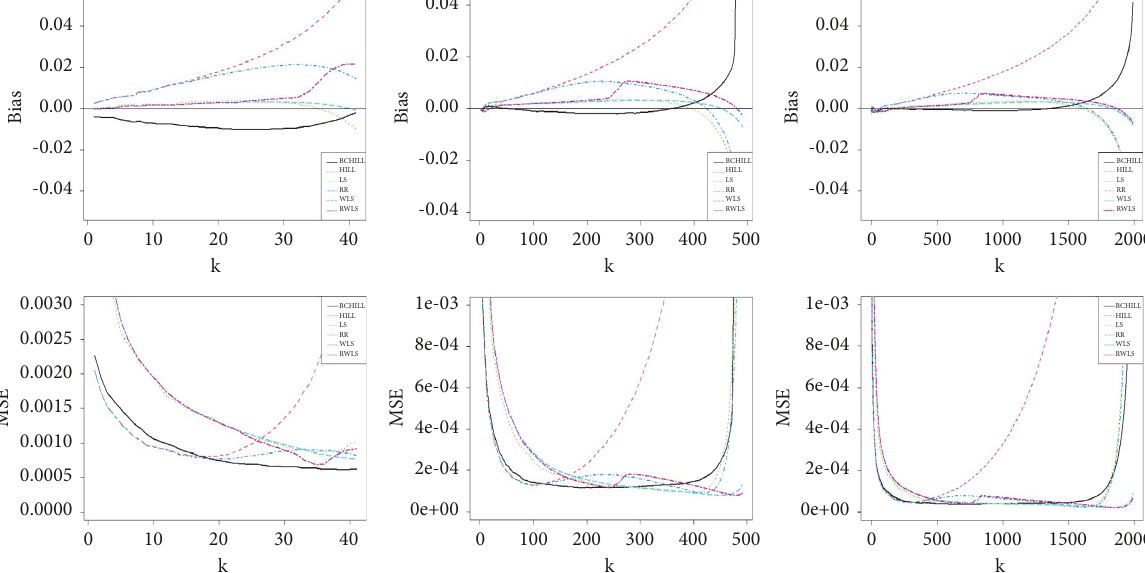
Figure 4: Results for Fr´echet distribution with c � 0 . 1: Bias (top row) and MSE (bottom row). First column: n � 50; second column: n � 500; and third column: n � 2000.